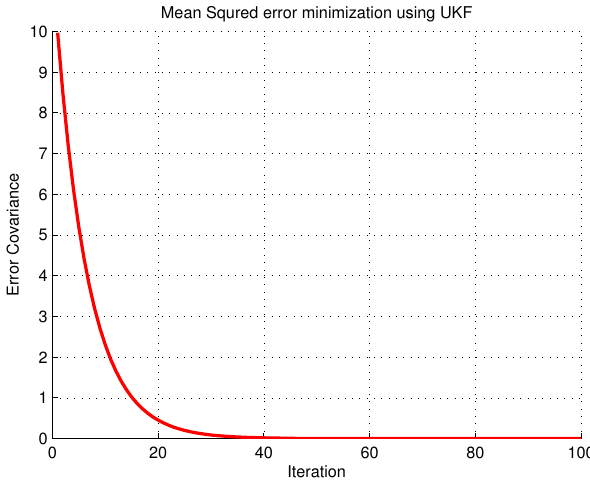
Figure 5. Converge estimated value to the actual value in a nonlinear system based on unscented Kalman filter (UKF) under the alternative hypothesis, H 1 at the i th CU with n = 2.